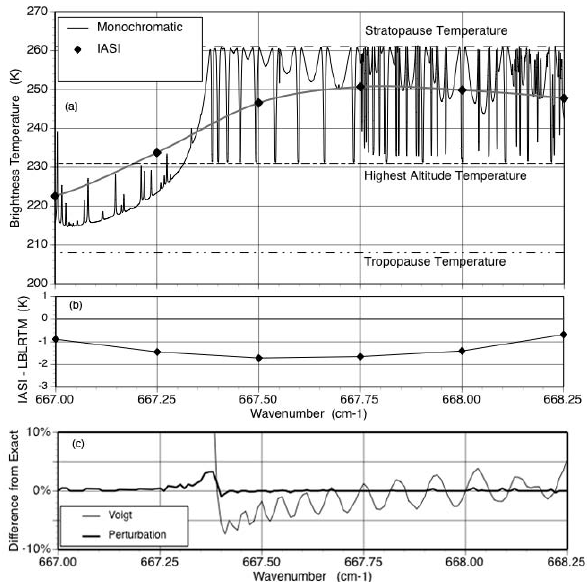
Fig. 16. Plot (a) shows the monochromatic brightness temperatures in the region of the 667cm − 1 Q-branch. The 1/e value of the IASI Gaussian instrument function is at − 0.25 and +0.25 of the nomi- nal wavenumber value, i.e. the plot grid lines. The temperatures at the tropopause, highest altitude in the profile and stratopause are shown for reference. Plot (b) shows the IASI-LBLRTM residuals over this spectral domain. Plot (c) shows the difference between the exact line coupling calculation and the calculations using 1st order perturbation theory (thick “Pertubation” line) and no line coupling Voigt line shape (thin “Voigt” line).